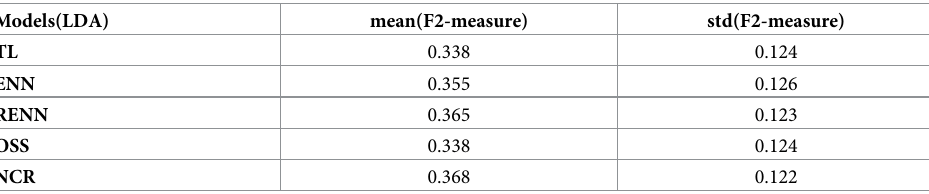
Table 4. F2-measure of LDA.